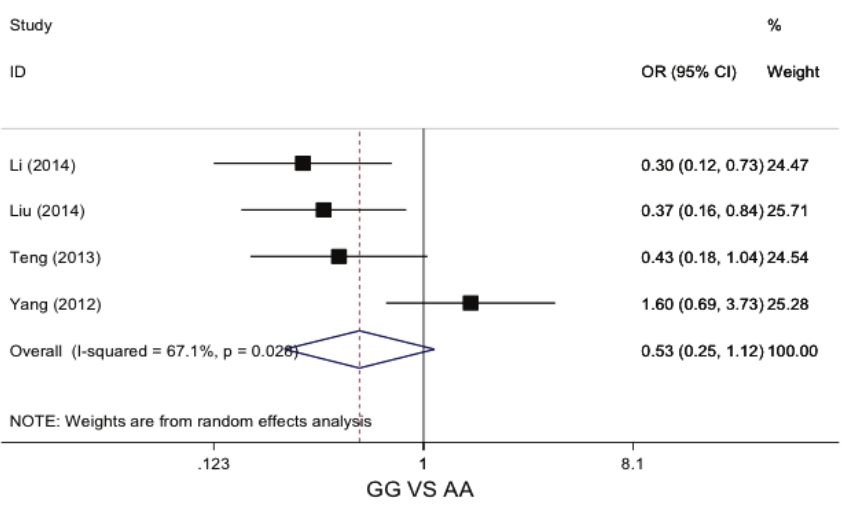
Figure 1: Forest plot of GSTP1 A>G polymorphisms and chemosensitivity of osteosarcoma in omozygous genetic model (GG vs AA)